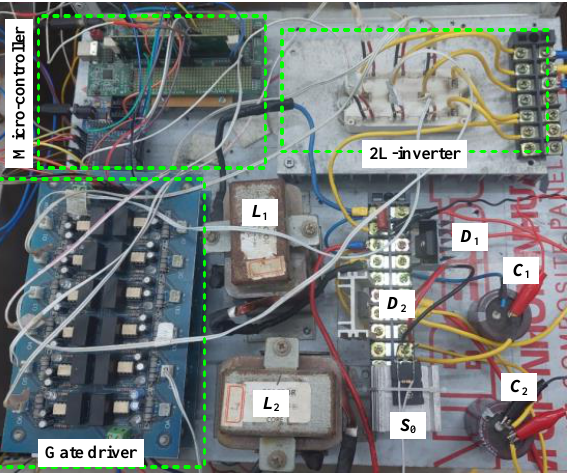
Figure 9. Experimental Prototype.